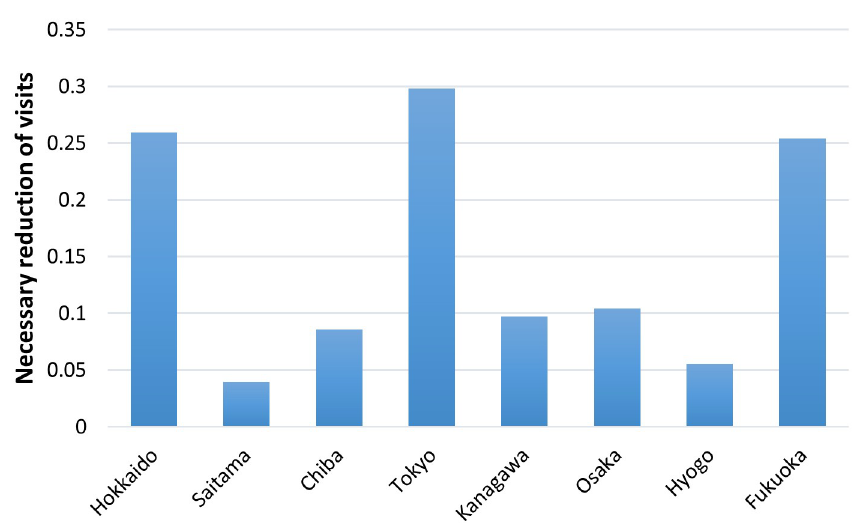
Fig 5. Necessary reduction level of visits to hospitality sector businesses to achieve R(t) < 1 for “100% of days”.